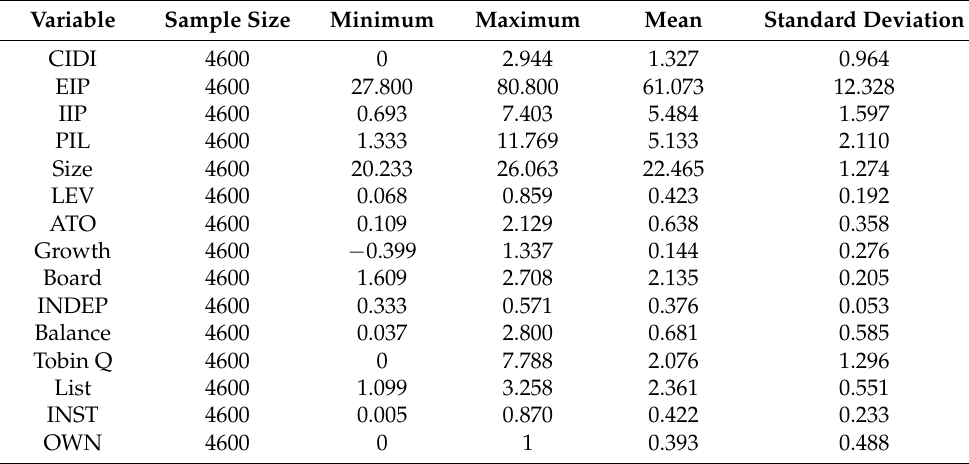
Table 3. Descriptive statistical analysis